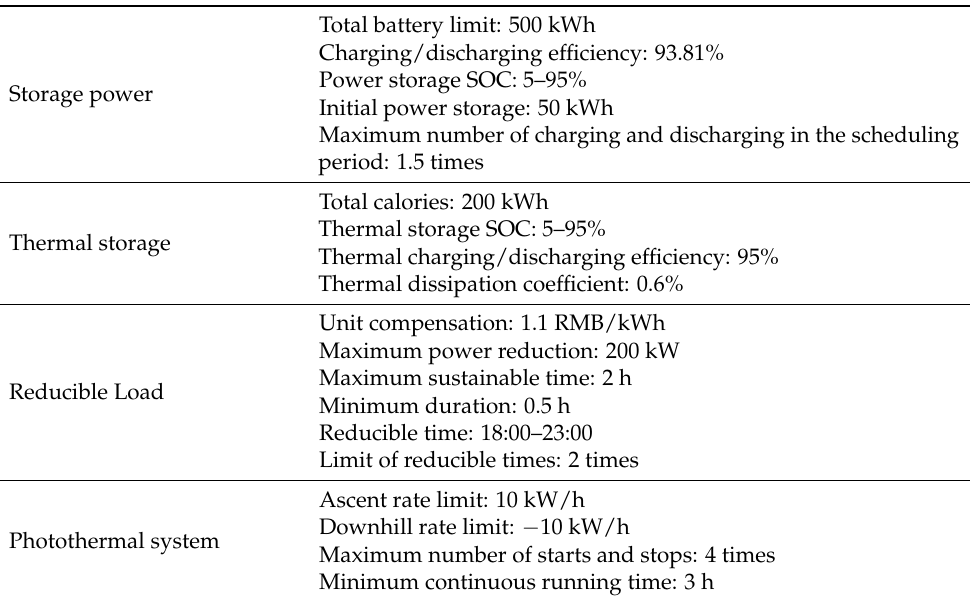
Table 3. Other system